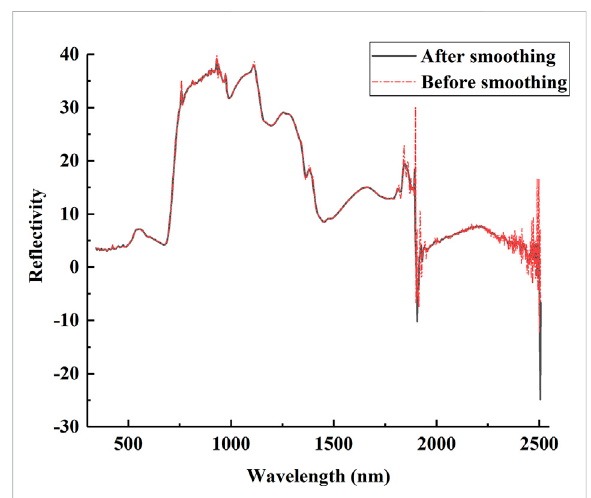
Figure 2A. The monitoring range of the spectrometer probe is presented in Figure 2B. The identi fi cation of S. vulgaris refers to “ fl ora of China ” and “ Chinese Virtual Herbarium. ” The number of S. vulgaris is LZD0000136.